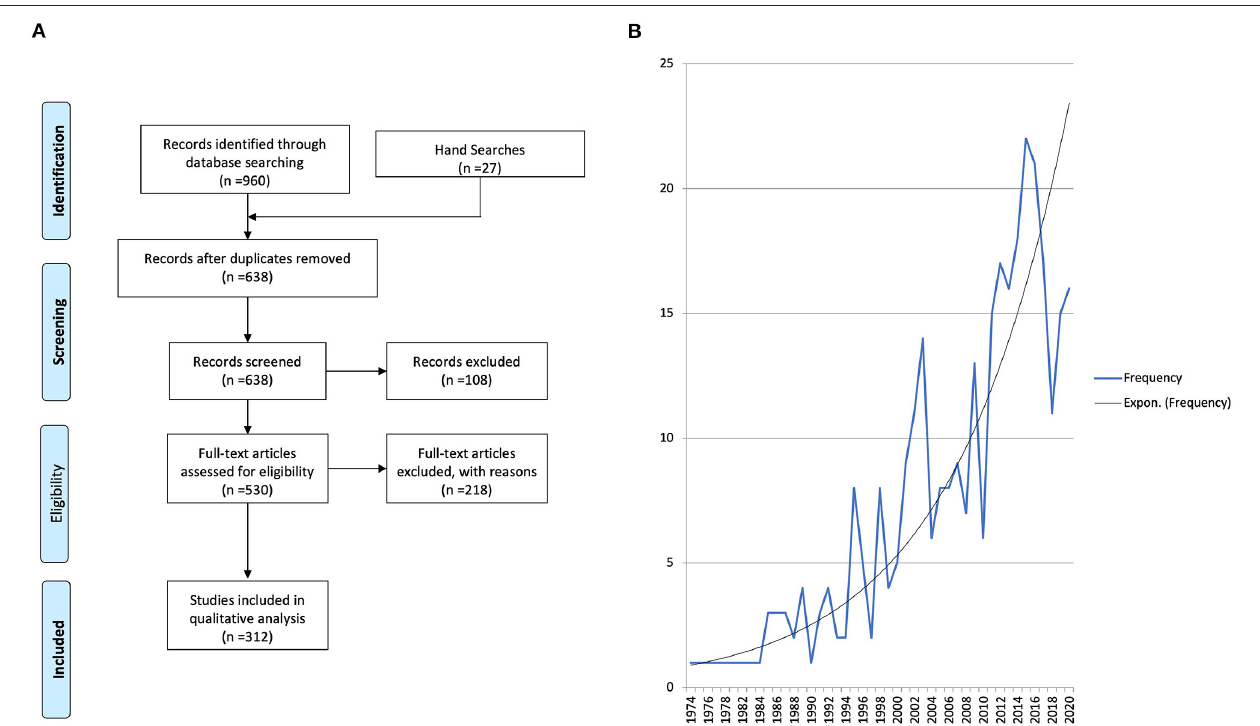
FIGURE 2 | (A) PRISMA flow diagram. Two hundred and eighteen articles were excluded with the following reasons: full text not available ( n = 103), no treatment details ( n = 29), no primary data ( n = 20), conference abstract only ( n = 18), unable to extract individual patient data ( n = 13), insufficient clinical information ( n = 12), articles not in English or Spanish ( n = 9), molecular/immunohistochemistry studies only ( n = 8), no malignant odontogenic tumour present ( n = 4), and non-human cases ( n = 2). (B) Frequency of publications included in this review over time with an exponential line of best fit